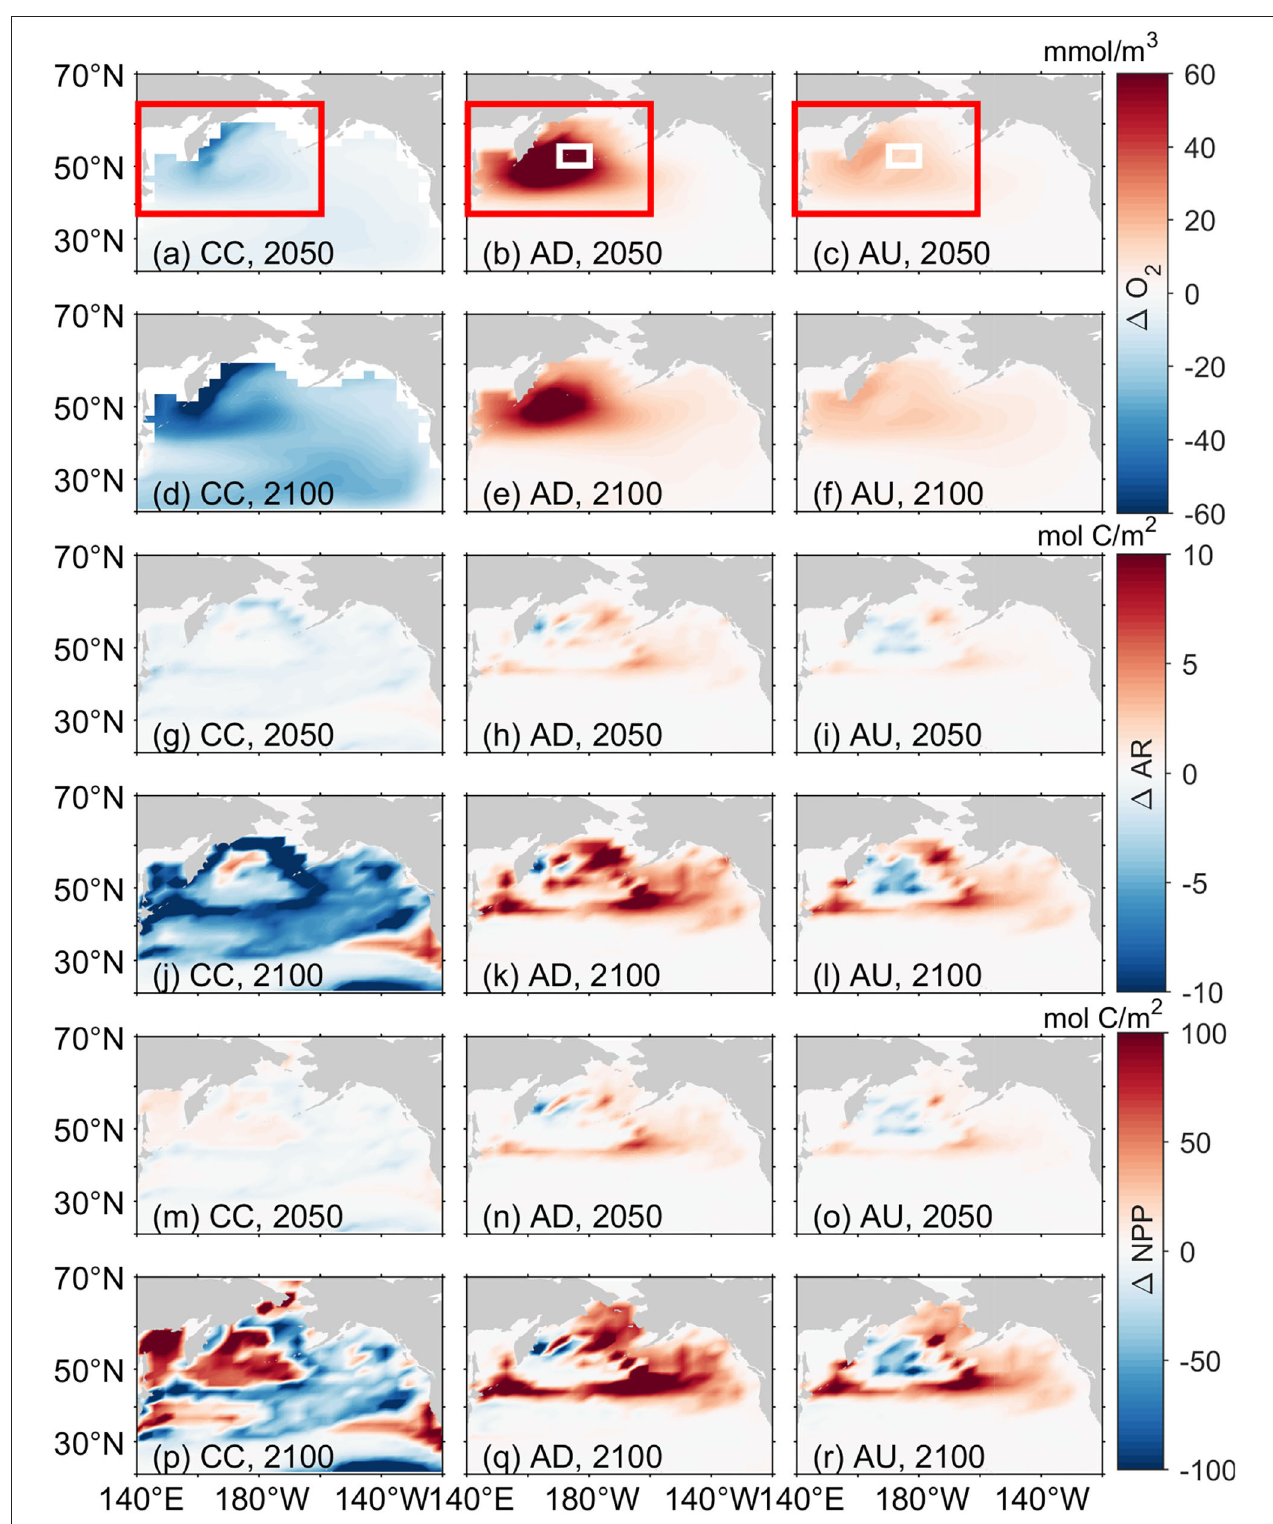
FIGURE 3 | Field anomalies caused by climate change (CC, left), artificial downwelling (AD, middle), and artificial upwelling (AU, right) at year 2050 and 2100: (a–f) oceanic oxygen at 457.5 m (i.e., model level 5); (g–l) cumulative aerobic remineralization (240–960 m); (m–r) cumulative net primary production (0–240 m). Cumulative time periods are from year 2020 to 2050 or 2100. The impacts of climate change here and in other figures are calculated as differences from year 2020 background field; the impacts of AD and AU here and in other figures are calculated as the differences of their standard simulations relative to the reference simulation at the same model year (Red box: WSNP; white box: locations of pipe